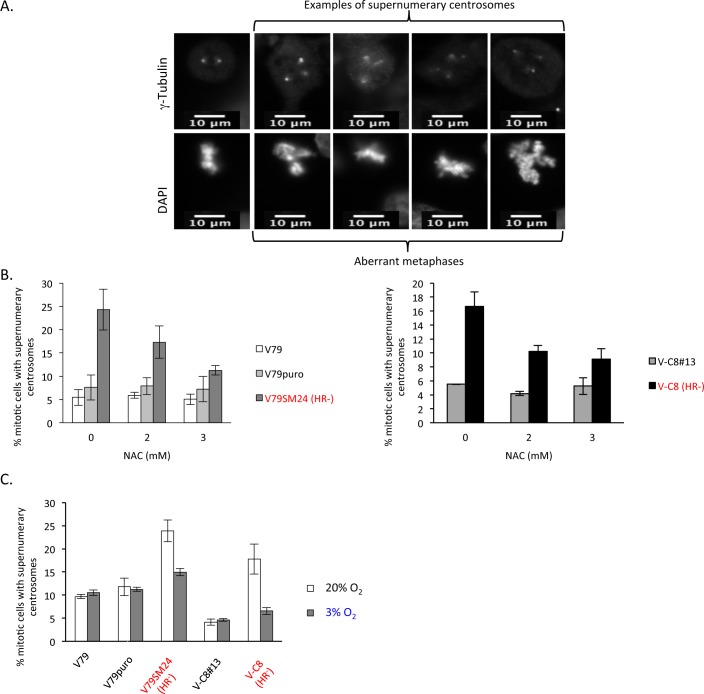
Impact of NAC or low O2 levels on supernumerary centrosomes in mitotic cells (MEC).A/ Examples of labeled centrosomes in mitotic cells (see chromosomal DAPI staining in lower panels). Left photograph: normal centrosome number (= 2); right photographs: aberrant centrosome numbers (≠2) leading to metaphase alterations (see DNA labeling in lower panels). Scale bar, 10 μm. B/ Frequencies of mitotic cells with aberrant centrosome numbers. Left histograms: V79 cells and derivatives; right histograms: V-C8 cells and derivatives. C/ Impacts of a low level of O2 (3%) on MECs. The mean value +/- s.d. was calculated from at least three independent experiments. In total, 150 mitoses were scored for each experiment and condition.